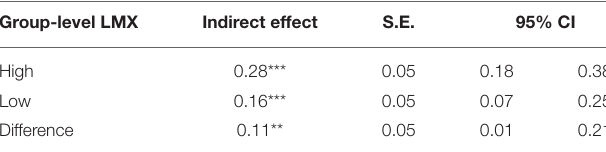
TABLE 4 | Moderated mediating effect of self-efficacy on the relationship between autonomy-oriented help and work role performance at different LMX levels.